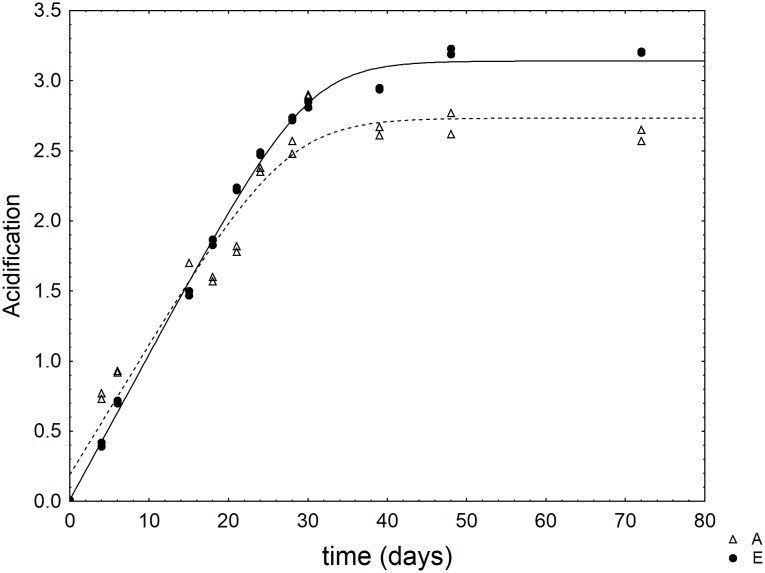
Kinetic of acidification of L. acidophilus in some selected combinations of the mixture design (Table 1). The lines represent the best fit through the lag-exponential model.